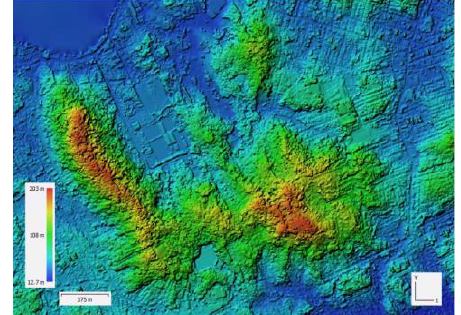
Figure 14. DEM generated to give birth of photos acquired with RPAs